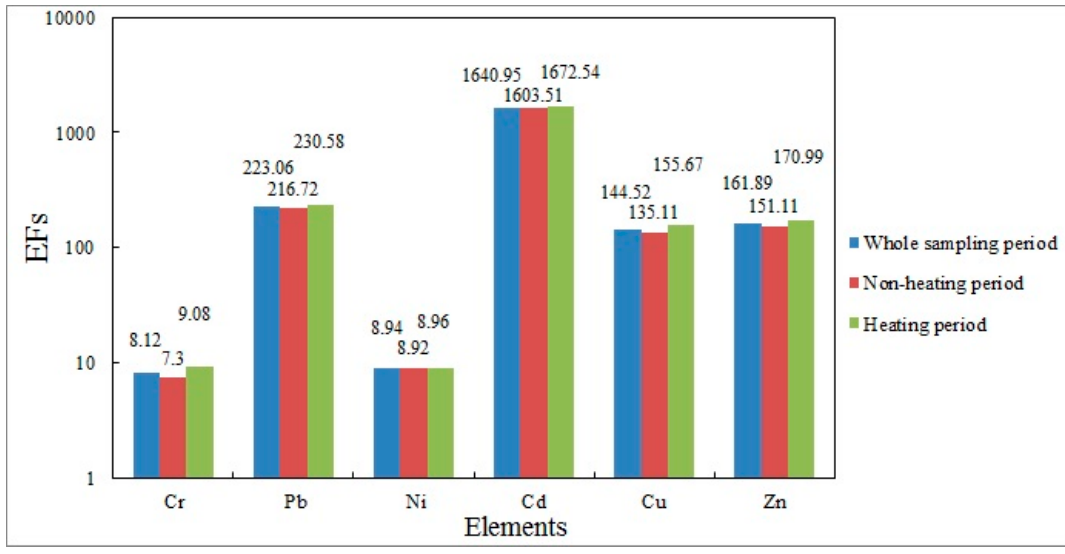
Figure 2. The EF values of heavy metals.